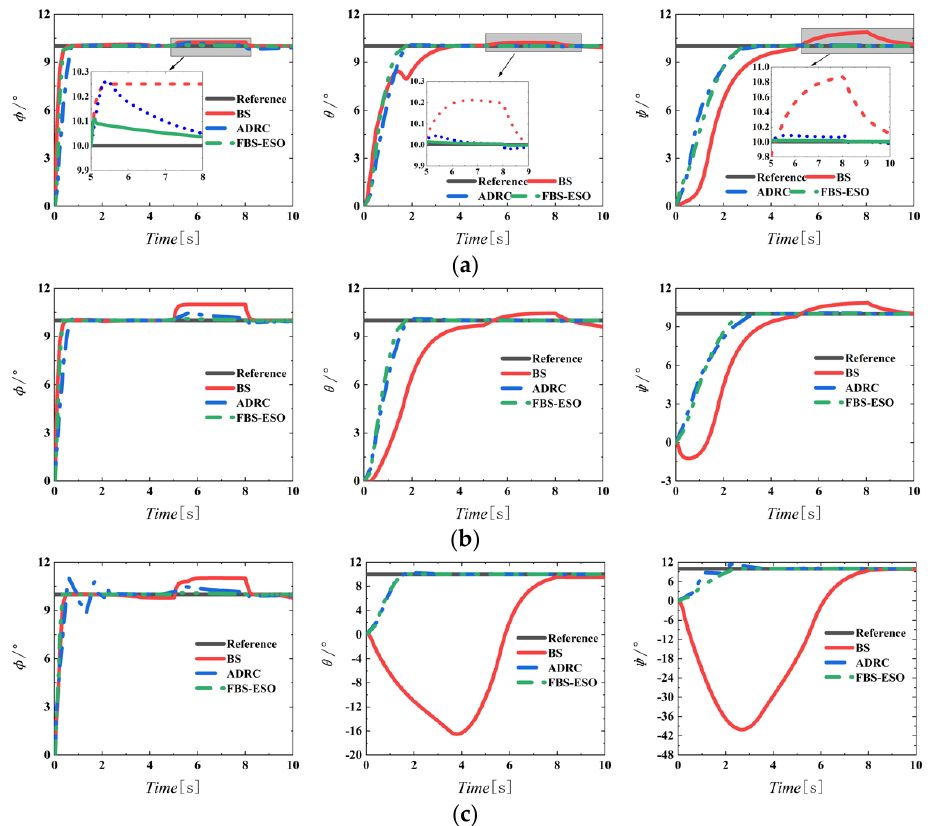
Figure 8. Response curves of the anti-disturbance tests. ( a ) β t = 90 ◦ (helicopter mode); ( b ) β t = 45 ◦ (transition mode); and ( c ) β t = 0 ◦ (fixed-wing